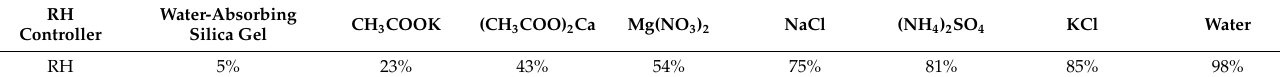
Table 2. Saturated salt solution and water-absorbing silica gel for controlling the RH.